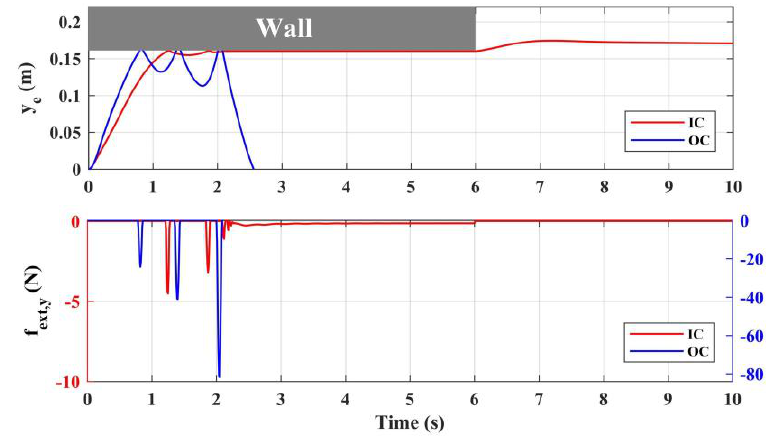
Figure 9. System responses during contact.